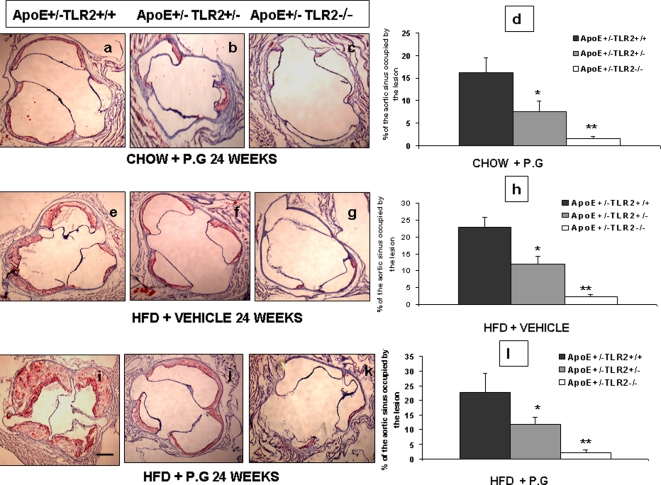

P.g and/or high fat diet increases atherosclerotic lesions in proximal aorta of ApoE+/−-TLR2+/+ mice when compared to ApoE+/−-TLR2+/−, and ApoE+/−-TLR2−/− mice.Microscopic cross-sections (10 µm) of the proximal aortic root were stained with Sudan IV and counterstained with hematoxylin to reveal lipid deposition, which was quantified by digital morphometry. (3A–D): results from mice maintained on a standard chow diet and inoculated weekly with P. g (CP). (3E–H): results from mice maintained on a high fat diet and inoculated weekly with vehicle (HS) (normal saline). (3I–L) results from mice maintained on a high fat diet and inoculated weekly with P. g (HP). (3D, H, l): data are presented graphically as percentage of total lumen of the proximal aorta occupied by lesions after 24 weeks of injections. Values represent means±SD; *p<0.05 between ApoE+/−-TLR2+/+ mice and ApoE+/−-TLR2+/− mice; **p<0.05 between ApoE+/−-TLR2+/+ mice and ApoE+/−-TLR2−/− mice in the same condition and maintained on the same diet. Abbreviations are as defined in the text. Photomicrographs shown are representative images obtained at the end of the 24 week treatment period. Original magnifications 20×. Scale bar represents 0.5 mm.